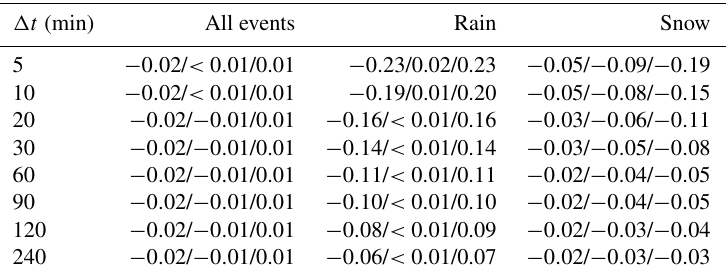
Figure 8. Comparison of particle size distribution (PSD) obtained by the Thies disdrometer and the two-dimensional video disdrometer (2DVD) during the whole time series (2 years). (a) Summed PSD during all observed rain and snowfall events. The separation into rain and snowfall events is based on the recorded dominant precipitation type by the Thies disdrometer (1min). (b) Resulting correction factors for different diameter classes of the Thies disdrometer, using the 2DVD as a reference. Thereby, the median and variability of these correction factors is shown using monthly results (each box shows the interquartile range of the distribution, while the whiskers extend to 1.5 times this range from the box or to the most extreme data point). Table 4. Biases in precipitation intensity measurements of the Thies disdrometer during the second year of measurement using the OTT pluviometer as a reference. The absolute bias B (Eq. 6) of the uncorrected measurements is given for all events, as well as for rain and snowfall separately (left value). Furthermore, the effect of the two proposed correction methods is shown, i.e., the adjustment to the OTT pluviometer (middle value) and the two-dimensional video disdrometer (right value). The correction methods are thereby established during the first year of